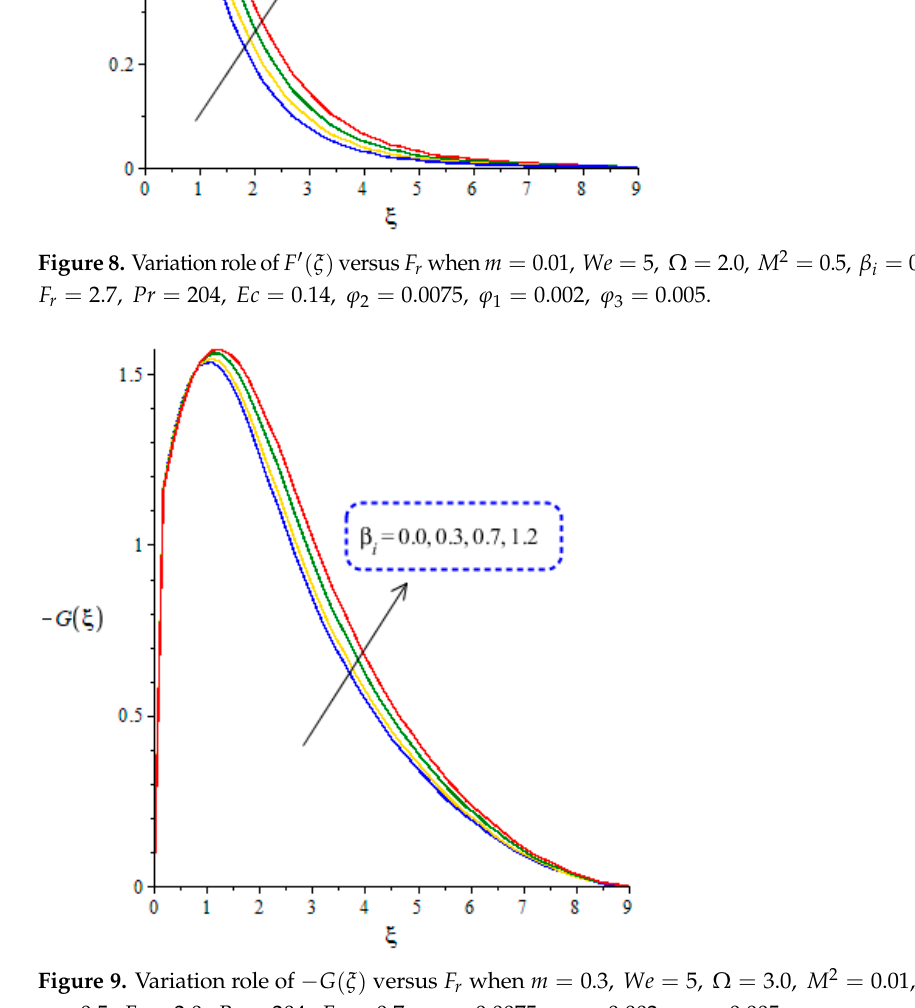
Figure 9. Variation role of − G ( ξ ) versus F r when m = 0.3, We = 5, Ω = 3.0, M 2 = 0.01, β e = 0.3, Figure 9. Variation role of −𝐺(𝜉) versus 𝐹 (cid:3045) when 𝑚 = 0.3, 𝑊𝑒 = 5, Ω = 3.0, 𝑀 (cid:2870) = 0.01,𝛽 (cid:3032) = (cid:101) = 0.5, F r = 2.0, Pr = 204, Ec = 0.7, ϕ 2 = 0.0075, ϕ 1 = 0.002, ϕ 3 =